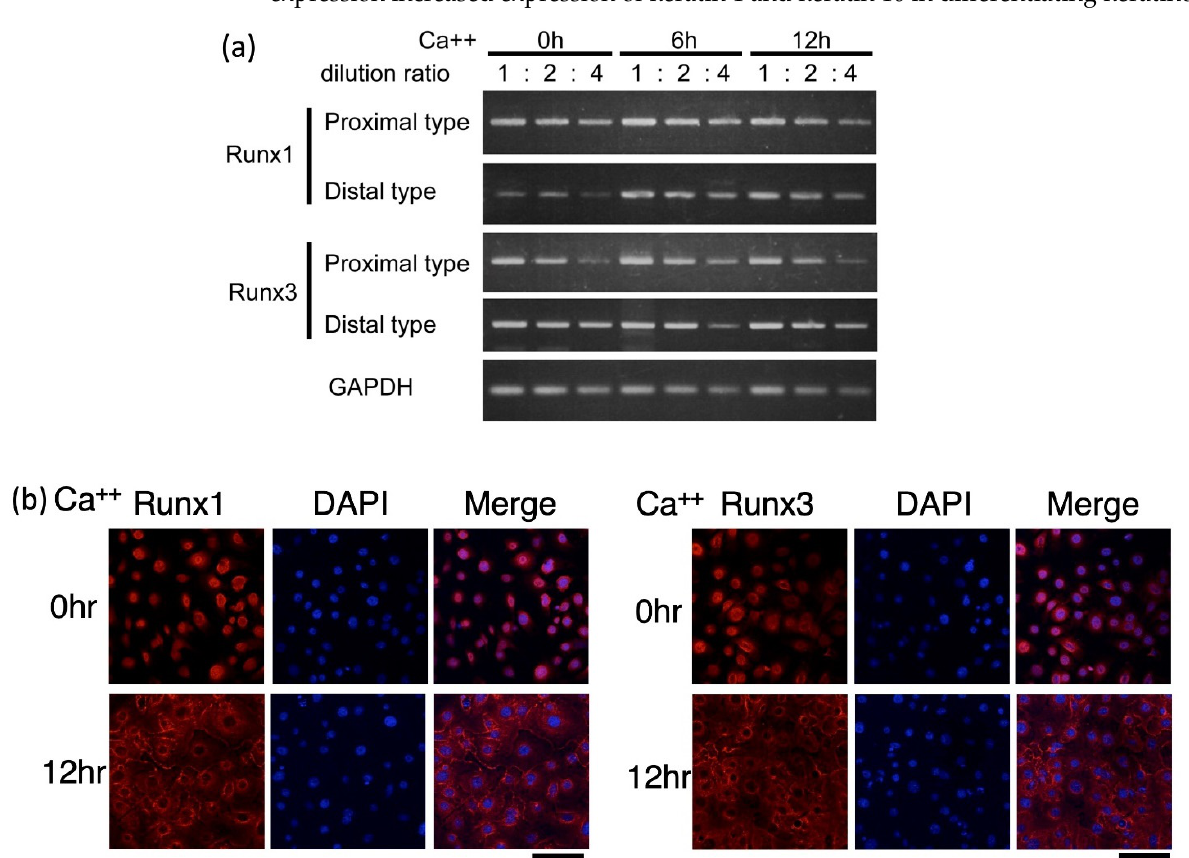
Figure 1. Expression of Runx1/Runx3 transcripts ( a ) and proteins ( b ) in cultured keratinocytes. The differentiation of keratinocytes was induced by increasing the calcium concentration in the medium for 0, 6, and 12 h of incubation as indicated. ( a ) RNA was extracted from the cells and processed for cDNA synthesis. Relative amounts of proximal and distal Runx1/Runx3 transcripts were evaluated by semi-quantitative PCR using the 1-, 2-, and 4-fold diluted cDNAs. GAPDH transcript was used as a control. The primers that were set to distinguish proximal versus distal type of transcripts yielded amplified products of rather long size. Since this made real time PCR experiments difficult to do, semi-quantitative PCR was chosen. Note that the purpose of experiments here was to confirm the presence of Runx transcripts but not try to measure the exact variation in transcript amounts. ( b ) Cells were fixed and immunostained for Runx1/Runx3 protein. DAPI was used to stain nuclei. Scale bar, 100 μ m. In both ( a , b ) we performed three independent trials for each experimental set out and could obtain essentially similar results. In the figure, representative results are shown.